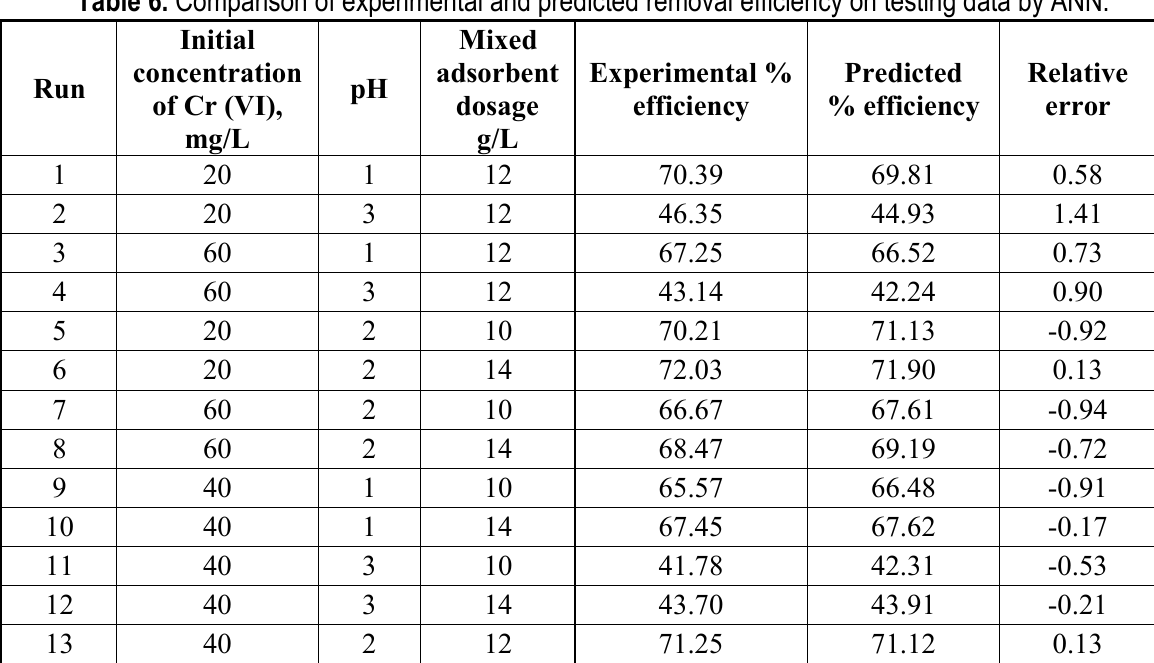
Table 6. Comparison of experimental and predicted removal efficiency on testing data by